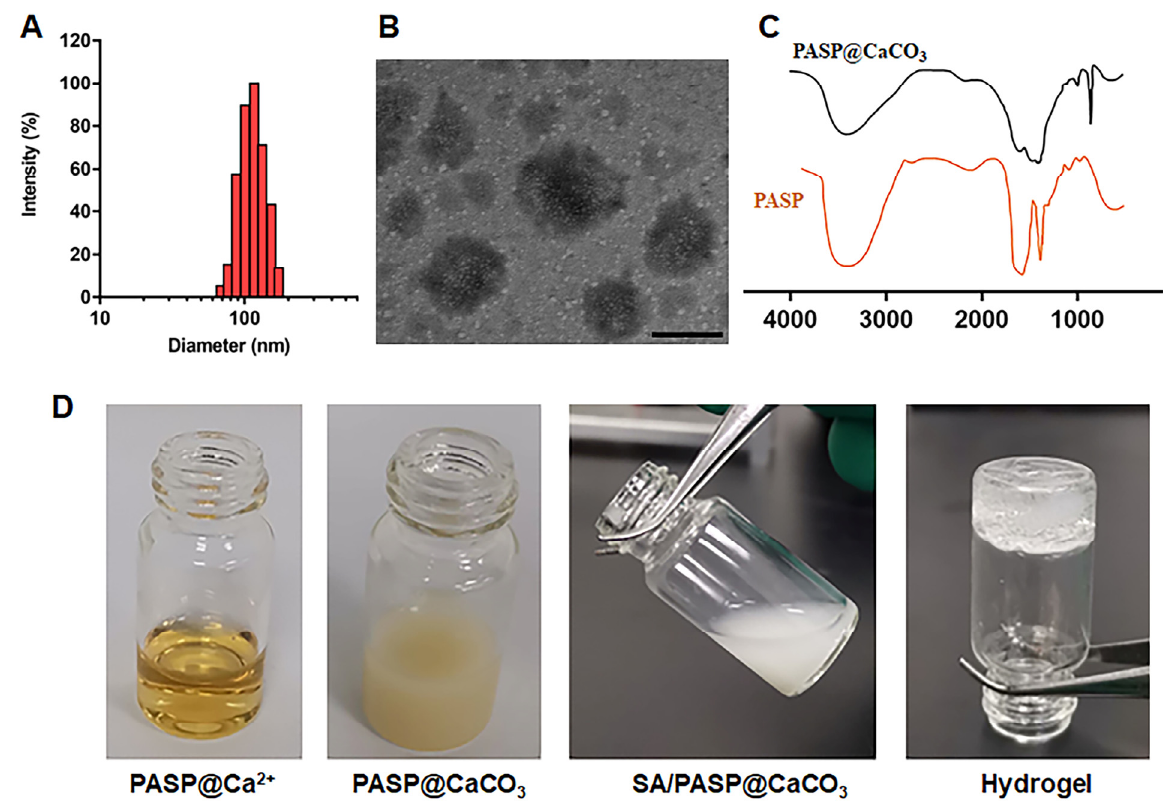
Figure 1. ( A ) DLS analysis of PASP@CaCO 3 NPs. ( B ) TEM of PASP@CaCO 3 NPs (scale bar: 100 nm). ( C ) FT-IR analysis of PASP and PASP@CaCO 3 NPs. ( D ) The gelation process of SA/PASP@CaCO 3 NPs.